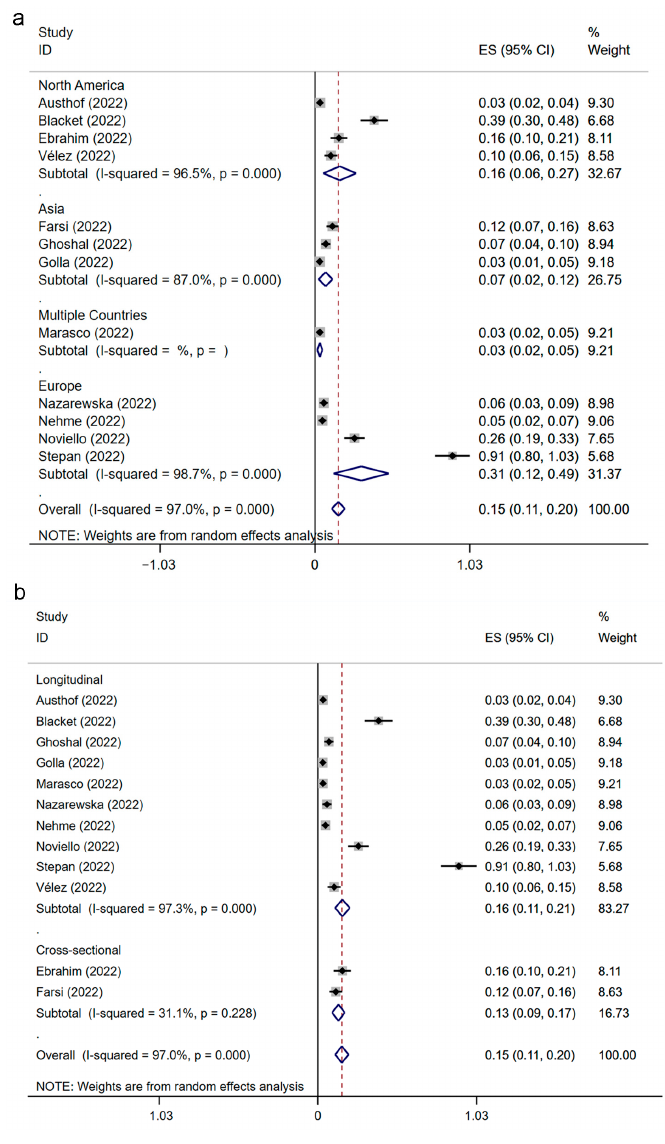
Figure 3. Subgroup analysis of IBS prevalence after SARS-CoV-2 infection [19–24,33–38]. Forest plots classified by region ( a ) and study design ( b ). IBS, irritable bowel syndrome; SARS-CoV-2, severe acute respiratory syndrome coronavirus 2; ES, effect size.